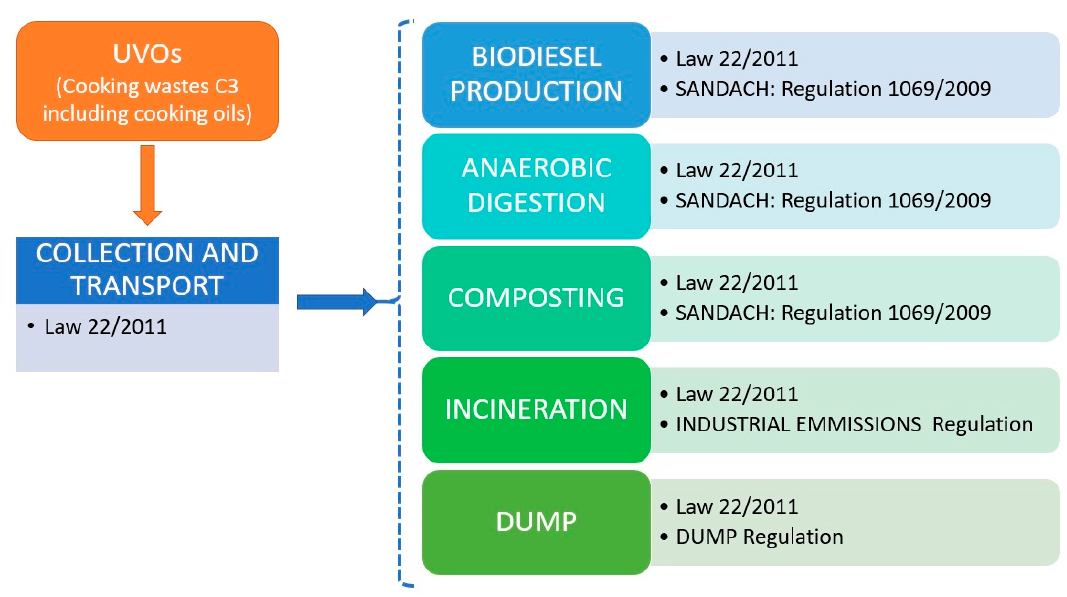
Figure 2. Overview of Spanish regulation involving used cooking oils’ collection and treatment. UVOs stands for Used Vegetable Oils, SANDACH for Subproductos Animales no Destinados al Consumo Humano, and DUMP Regulation is referred to the regulation related to the dumping of wastes in the environment.